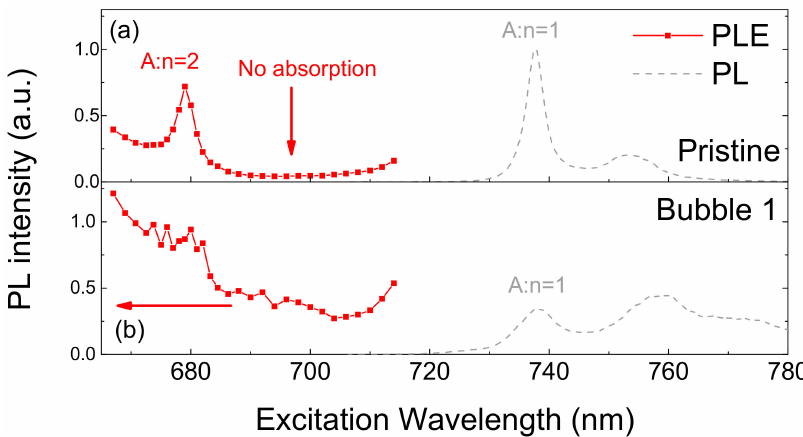
Figure 3. Excitation wavelength-dependent PL intensity at 80 K (red lines), and PL spectra from a pristine area and bubble 1 (dashed gray line). The PLE spectra indicate significant excitation wavelength-dependent emission characteristics for both bubbles and pristine areas in WSe 2